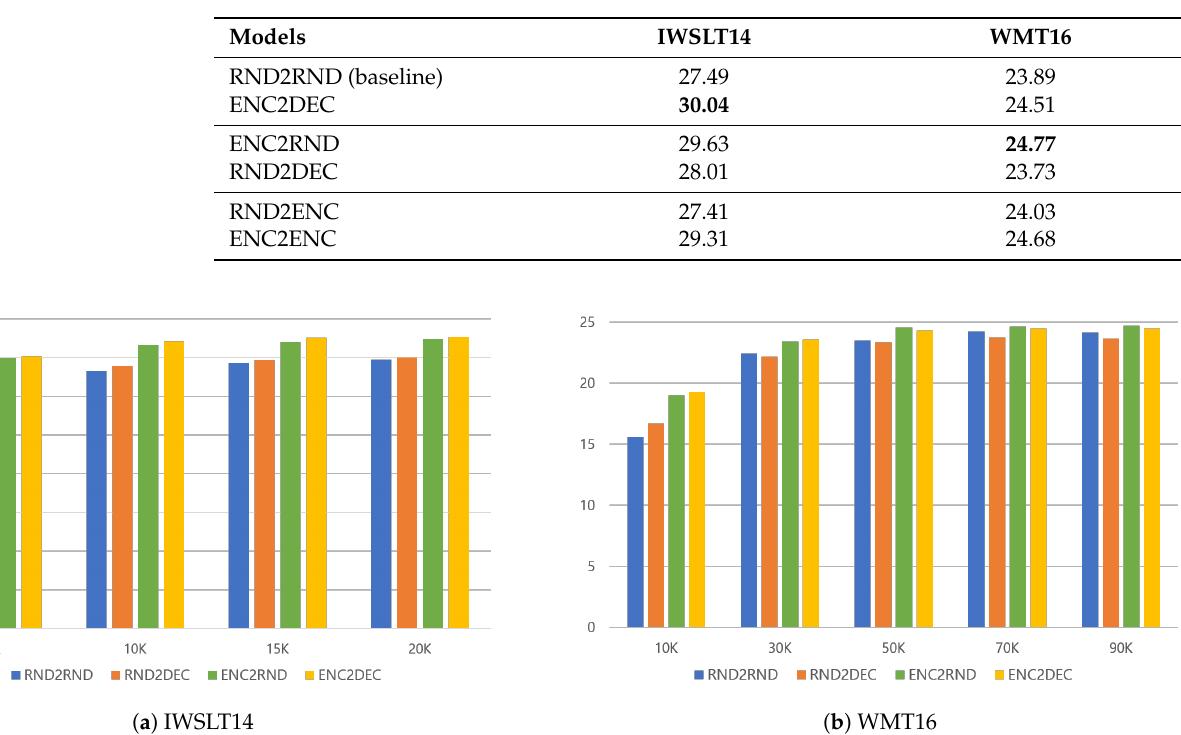
Table 6. BLEU scores of the IWSLT14 En-Ro dataset and WMT16 En-Ro dataset with partial pre- trained module reusing. We indicate the best scores with bold font.